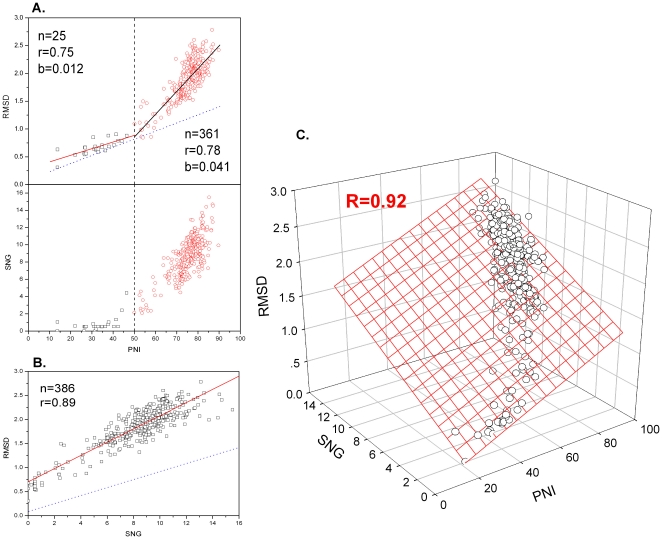
Bilinear correlation of PNI, SNG versus RMSD within the amylase catalytic domain family (AMC).A. The piecewise linear correlation of PNI-RMSD, which is related to the distribution of SNG. B. The linear correlation of SNG-RMSD. C. The bilinear correlation of PNI, SNG versus RMSD, illustrated by 386 accurate alignment results. The dotted lines in A, B show the real influence of PNI and SNG on RMSD, obtained by conducting bilinear regression, respectively.